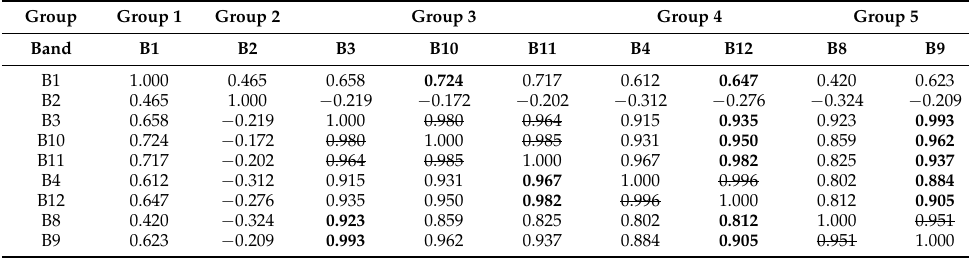
Table 2. Correlation coefficients between the nine MOD09 bands from five groups. Except for B2, the two highest correlations from two different groups for each band are marked in bold. Bands with the same group are excluded with a strikethrough. For example, B11 is divided into Group 3, and B3 and B10 (with the same group, Group 3) should be excluded first. We then found that the two highest correlations from the two different groups were 0.982 and 0.937 (i.e., B12 in Group 4 and B9 in Group 5). Group 2 Group 3 Group 4 Group 5